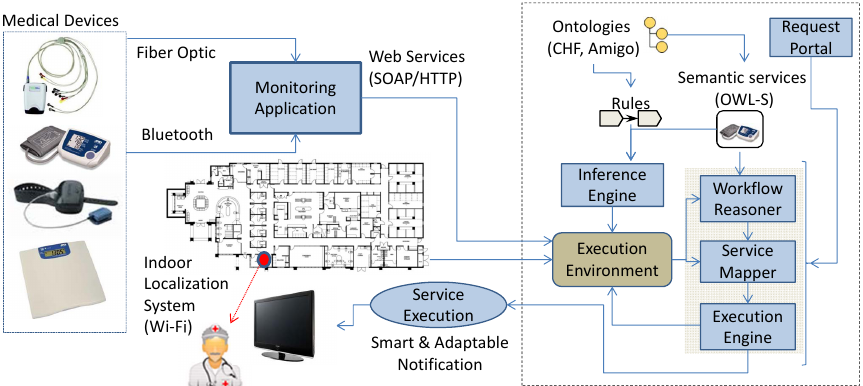
Ambient intelligence (AmI) patient monitoring and emergency detection framework